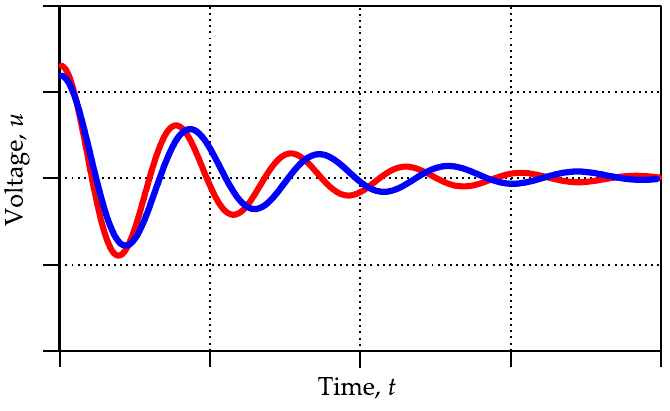
Figure 13. Example of surge test results.